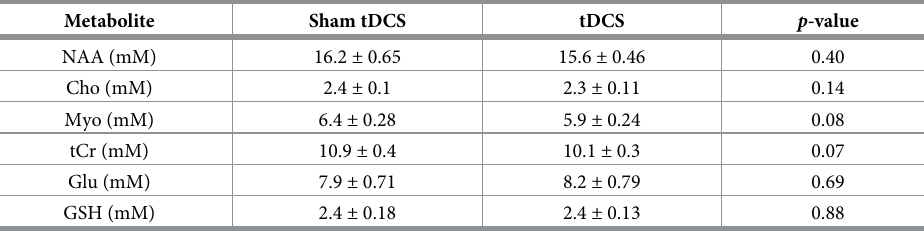
Table 3. Analysis of absolute metabolic concentration: Absolute concentration of metabolites measured by MRS. The p -values were measured by post-hoc analysis of individual metabolites using paired